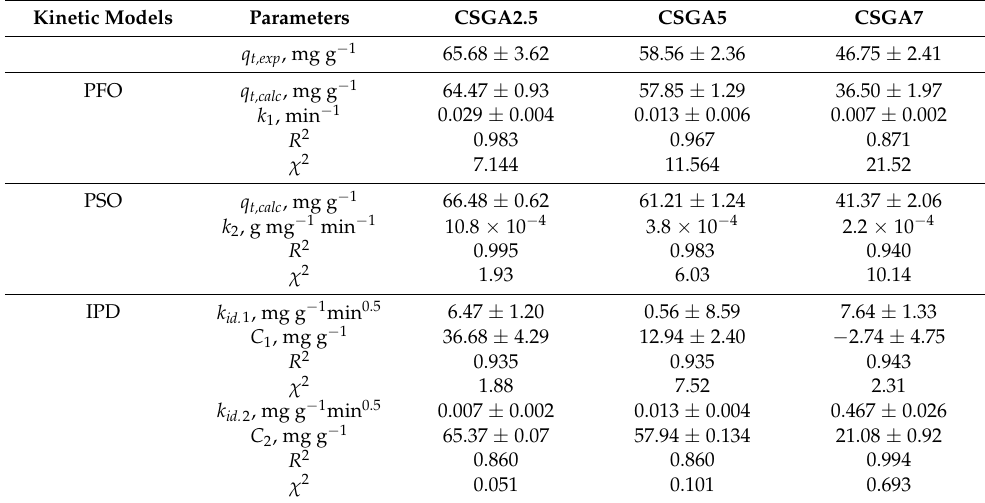
Table 2. Kinetic model parameters for the adsorption of Fastac 10EC onto CSGA sorbents. Kinetic